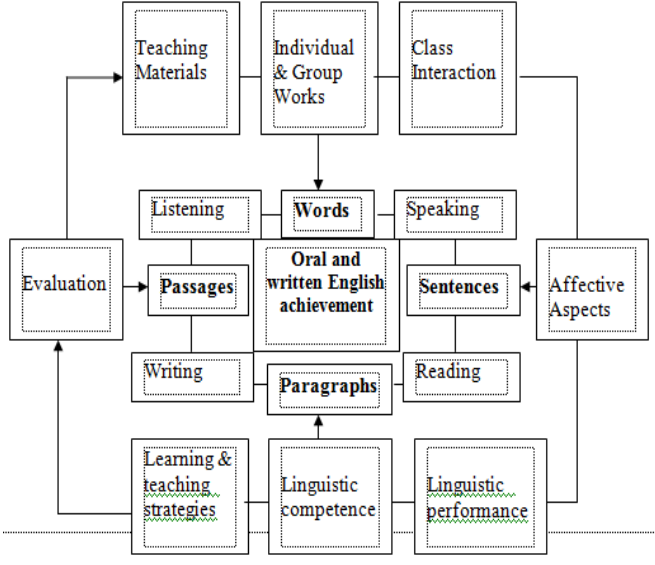
FIGURE 1 | The English teaching model of learning